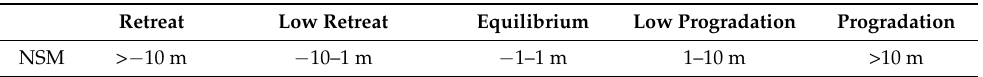
Table 2. Defined ranges to classify the net shoreline movement values and to assess predominant shoreline evolutive trends. Retreat Low Retreat